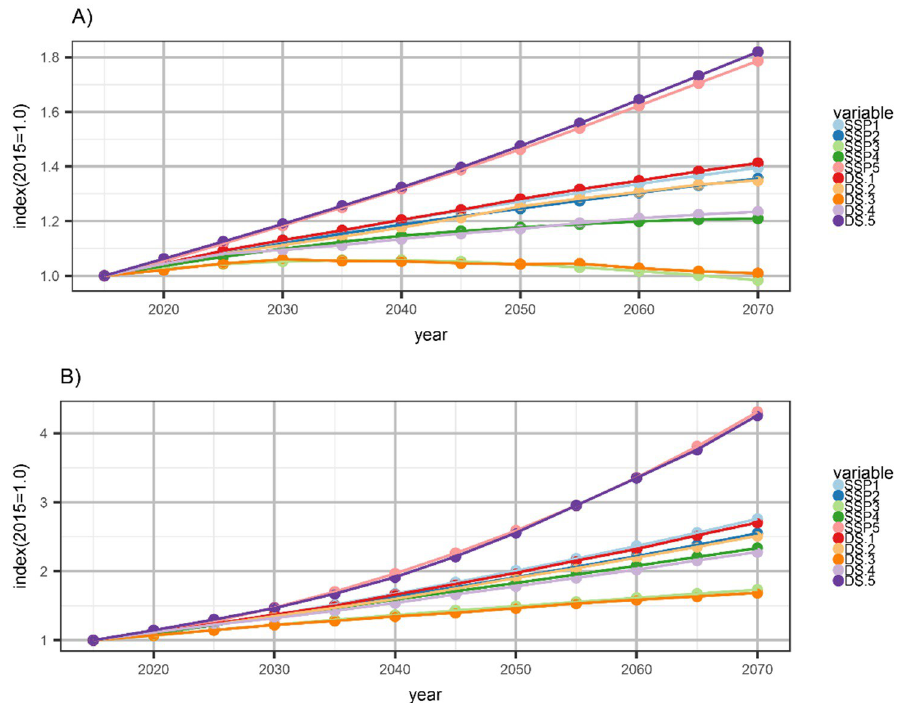
Fig 1. Population and GDP projections. Projections of indices of (A) US population, and (B) US Gross Domestic Product (in constant2005 dollars) projected for five Shared Socioeconomic Pathways indexed to a value of 1 in 2015. SSPx is the US projection for the referenced SSP. DS.x is the sum of the downscaled county-level projections for the referenced SSP.